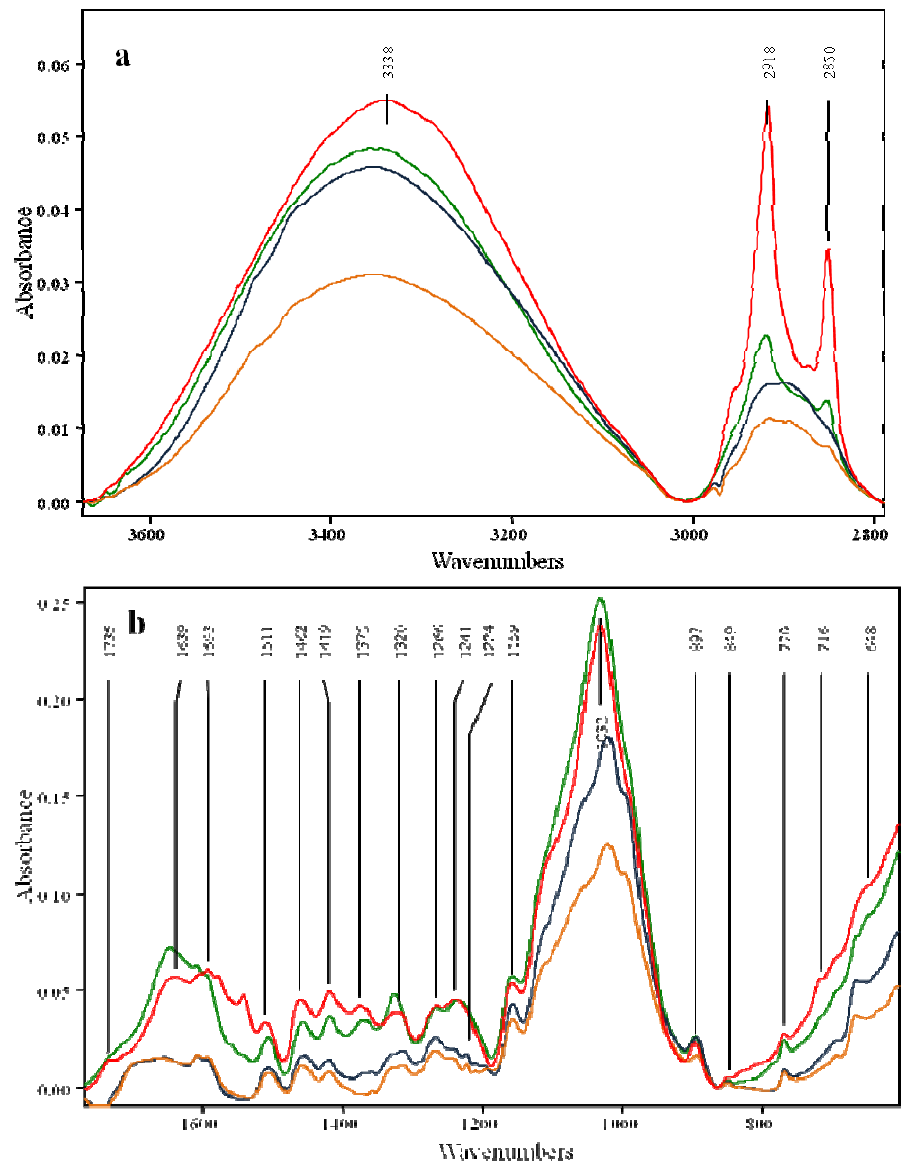
Figure 2. FTIR spectra of oil palm empty fruit bunches (OEPFB) in the wavenumber ranges of 2,800–3,800 cm − 1 and 600–1,800 cm − 1 . Line assignment: untreated (red line), fungal pretreatment (green line), phosphoric acid pretreatment (light blue line), fungal followed by phosphoric acid pretreatment (light brown